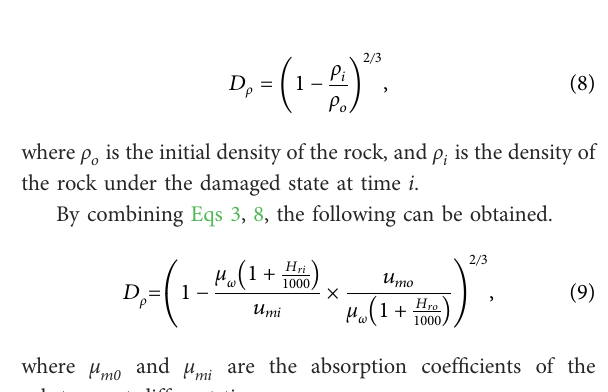
FIGURE 18 Relationship between F – T damage variables and number of F – T